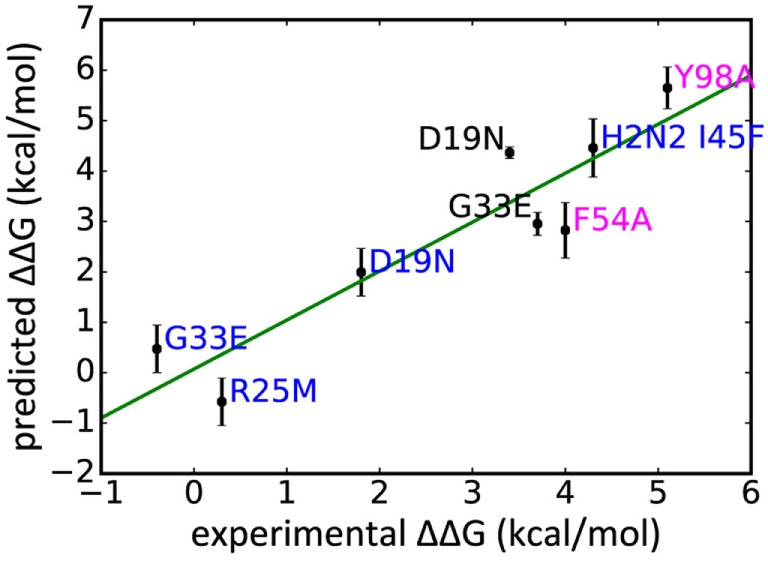
Experimentally derived ΔΔGbind for a range of substitutions compared with rescaled values predicted in this study, legend colored by Ab: CR9114 blue, CR6261 magenta, CR8020 black.